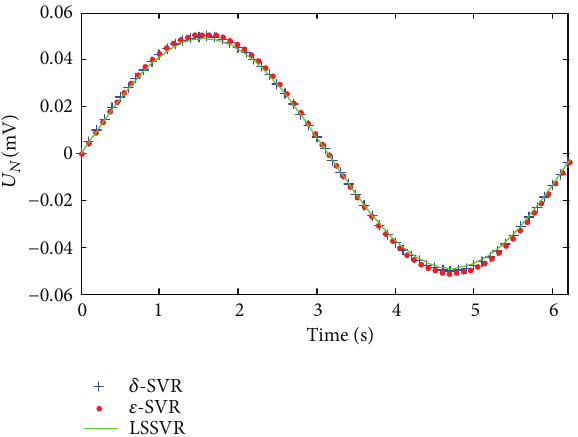
Figure4:Localregressioncurveofnoisevoltage( 𝑈 𝑁 )withthethree methods.